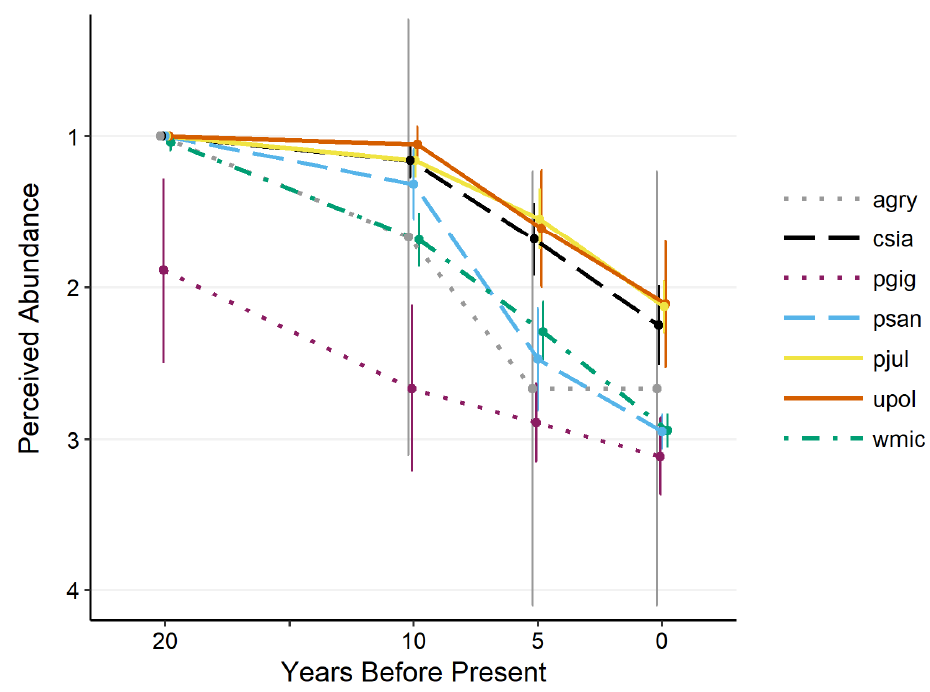
Figure 3. Perceived population abundance for Mekong megafishes in northern Cambodia in four discrete time periods over the last 20 years. Zero years before present indicates the time of the survey, June 2018. Data points and error bars represent the means and 95% confidence intervals of fishers’ rankings of population abundance. Rankings were: 1-common, 2-uncommon, 3-rare, and 4-extirpated. Sample sizes for each species are the total numbers of high-quality interviews for the whole study area reported in Table 2. For species abbreviations, see Table 1.